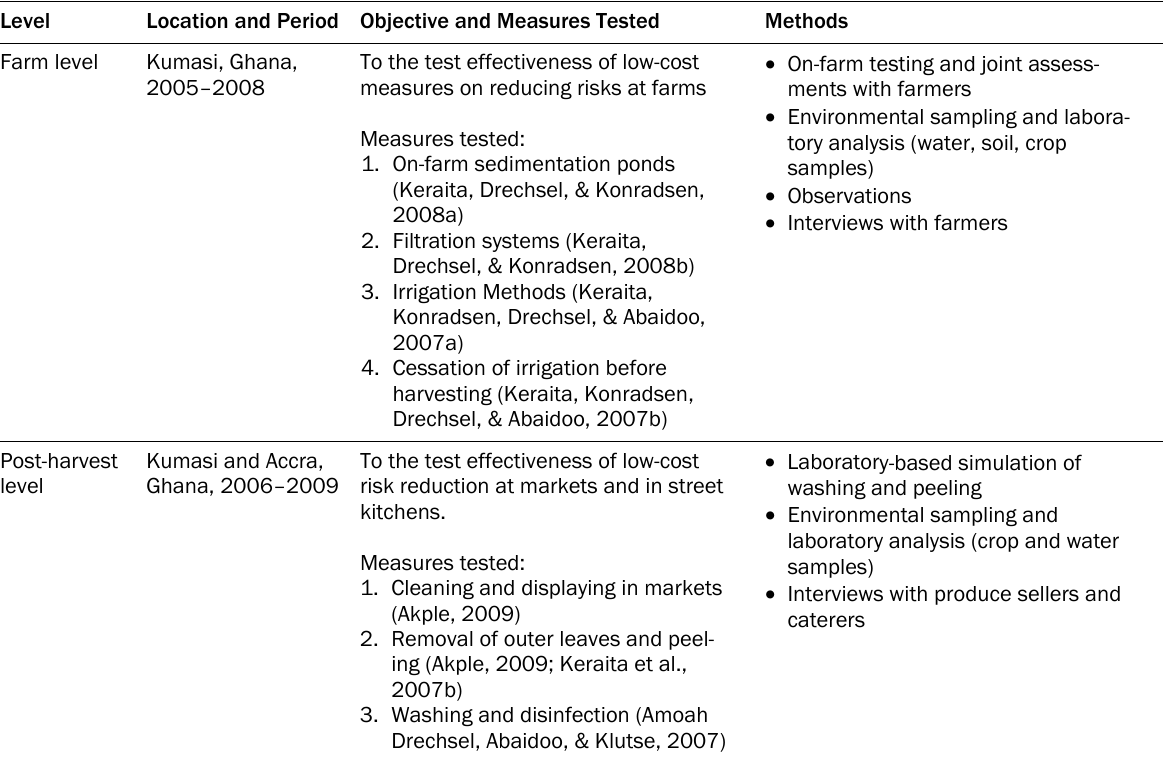
Table 1. Overview of Specific Studies for Testing and Assessing Risk Reduction